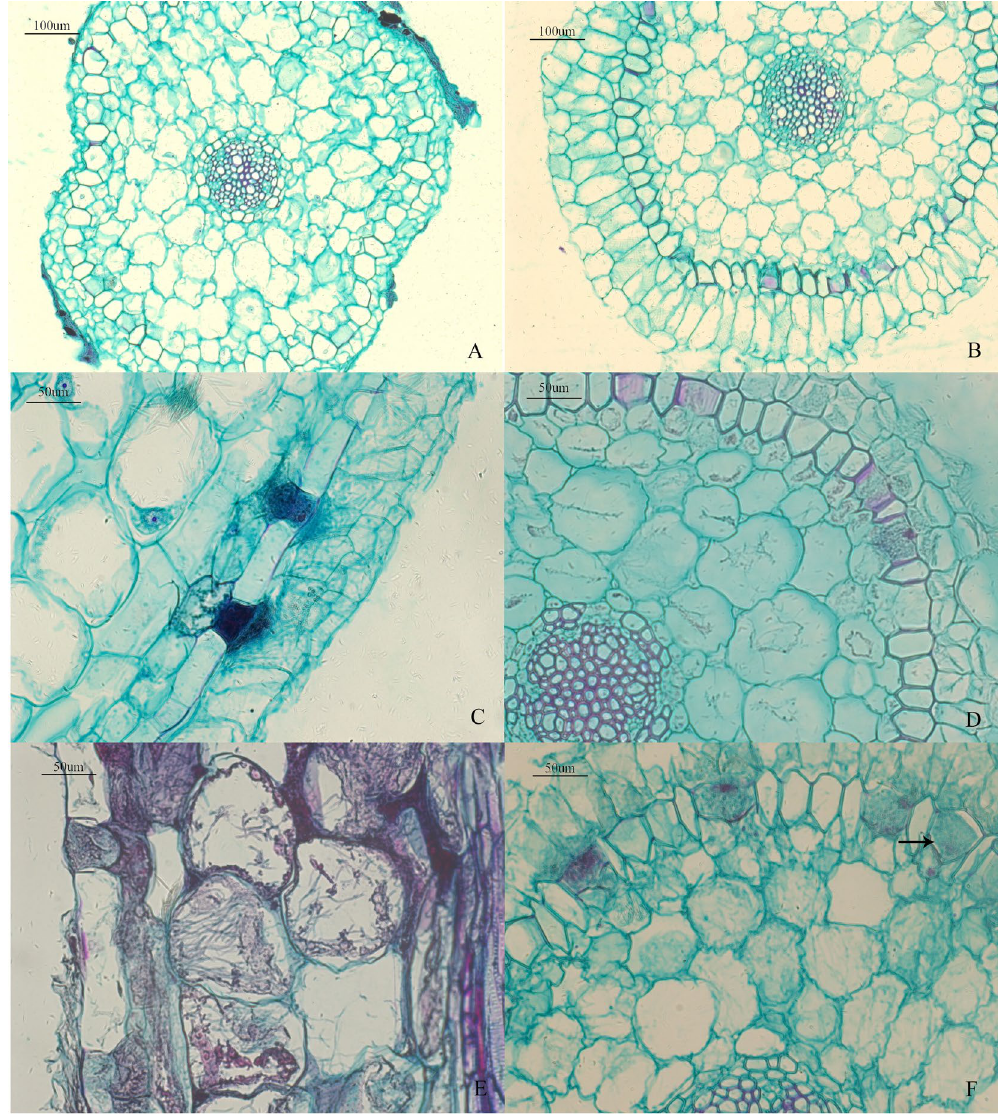
Figure 3. Light micrographs of interactions between the roots of D. nobile and MF23 ( A–F ). ( A ) Transverse section of the control ( × 10). ( B ) Transverse section of the root after 1 week of symbiotic cultivation ( × 10). ( C ) Vertical section of the root after 3 weeks of symbiotic cultivation ( × 20). Distribution of a large number of hyphae outside the passage cells of the exodermis. ( D ) Transverse section of the root after 6 weeks of symbiotic cultivation ( × 20). The hyphae penetrated the cortex cell walls and colonized neighbouring cells through passage cells into the cortical region. ( E ) Vertical sections of the root after 6 weeks of symbiotic cultivation ( × 20). Hyphae passed through the cell wall to progress towards the other cortical cells. ( F ) Transverse section of the root after 9 weeks of symbiotic cultivation ( × 20). The peloton was formed in the passage